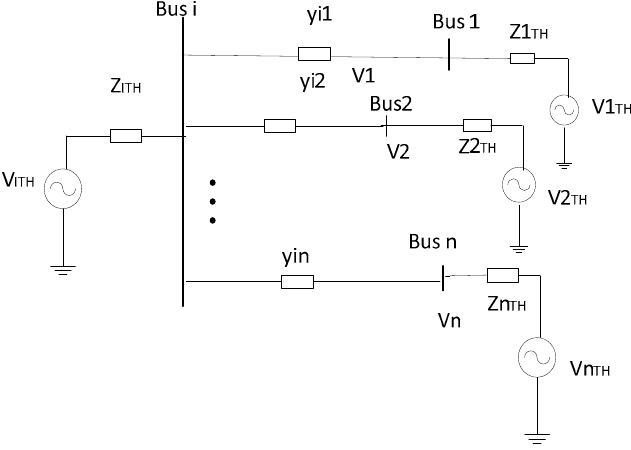
Figure 9. The equivalent Thévenin circuit model of a power network.